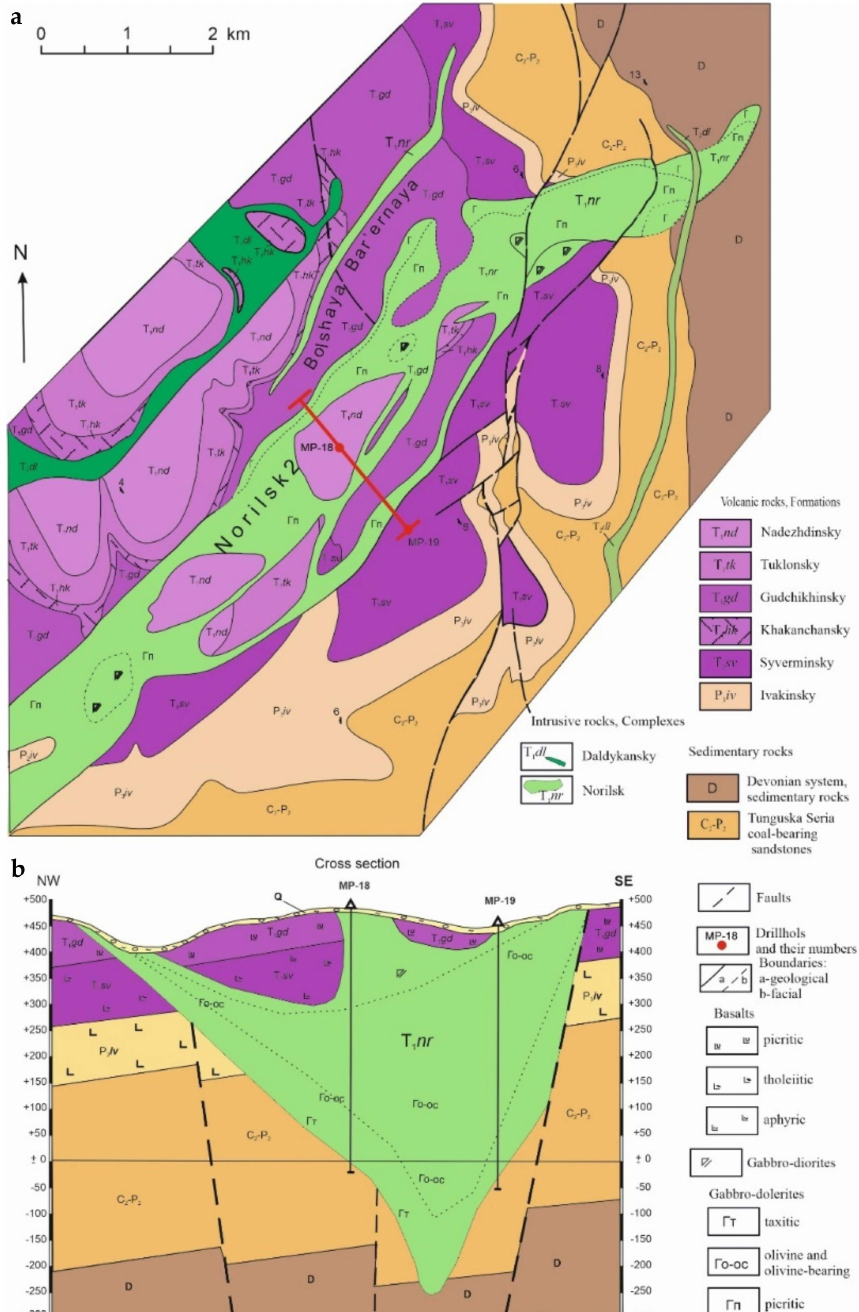
Figure 6. Geological map ( a ) and cross section ( b ) of the Norilsk 2 intrusion (after Norilskgeology Ltd. data, with the authors’ changes). The area is shown as “3” in Figure 2. Q—Quaternary